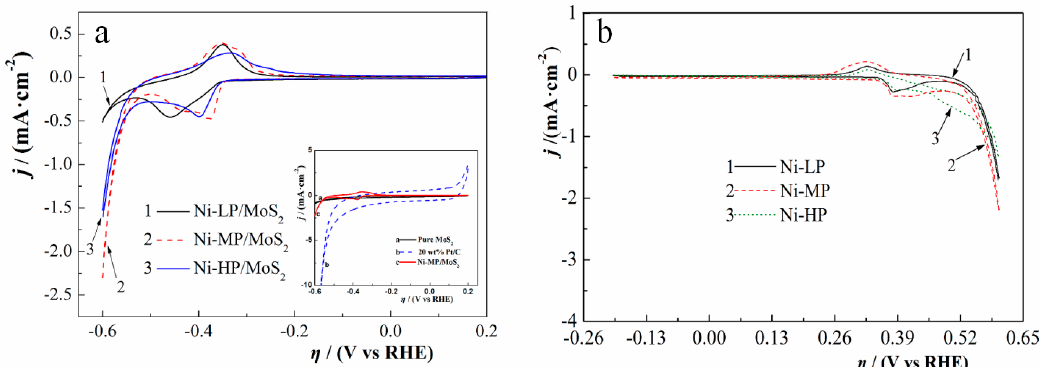
Figure 6. Cyclic voltammetry (CV) curves of the samples: ( a ) pure MoS 2 , 20 wt % Pt/C, Ni–LP/MoS 2 , Ni–MP/MoS 2 , and Ni–HP/MoS 2 . Scan rate: 10 mV/s, potential window: –0.6~0.2 V (vs. RHE); ( b )